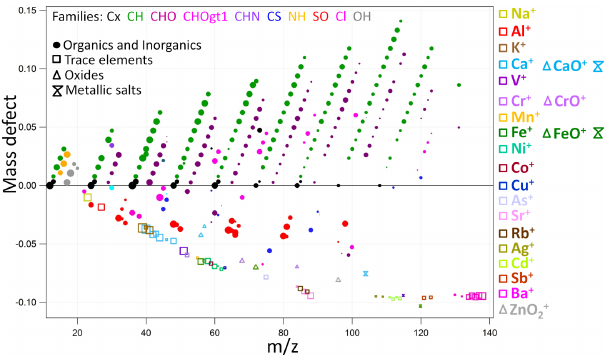
Figure 5. Mass defect (difference between the ion’s exact mass and its nominal mass) obtained from the emissions of a heavy-fuel-oil power plant; the size of the marker is proportional to the square root of the signal of each ion. Organic and inorganic ions are represented with circles, metals with squares, oxides with triangles, and metallic sulfates with double triangles.